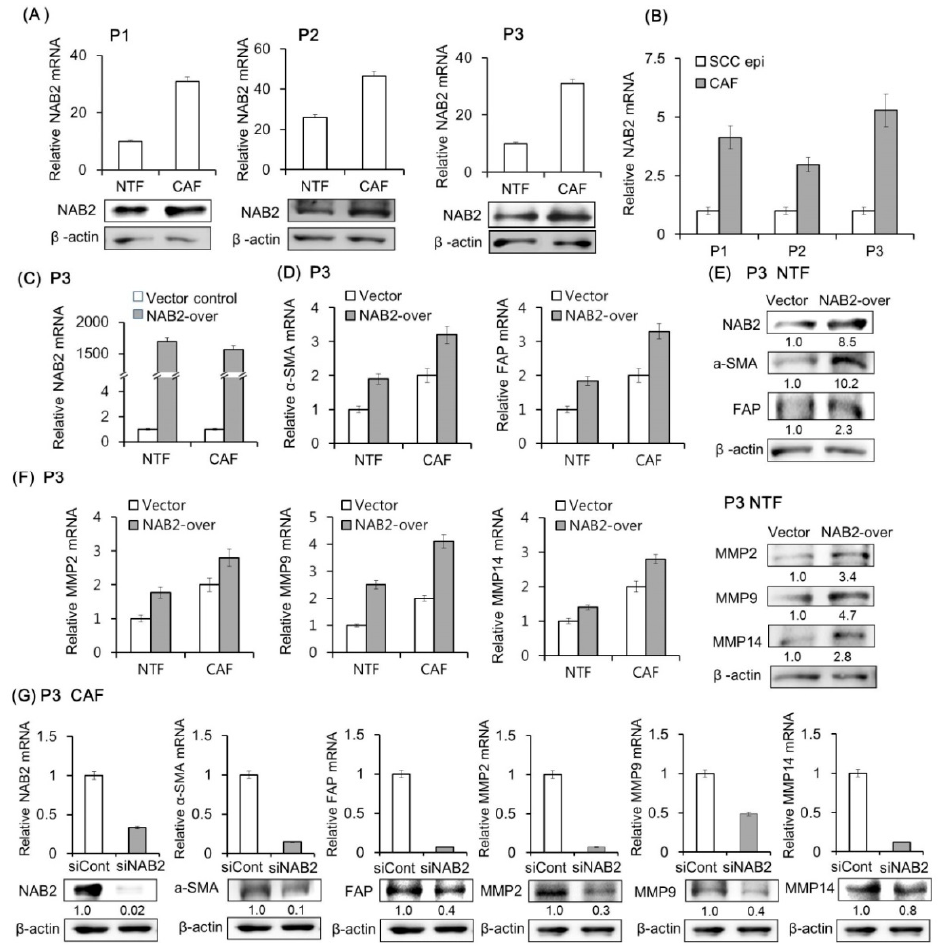
Figure 3. Effect of NAB2 on CAF marker and MMP expression in patient fibroblasts. ( A ) NAB2 mRNA and protein expression in CAFs and paired NTFs from tissue specimens of three HNSCC patients was analyzed by qPCR and Western blotting, respectively. ( B ) NAB2 mRNA level is compared in cultured CAFs and paired HNSCC tissues. ( C ) CAFs and NTFs form P3 were transfected with NAB2 overexpression (NAB2-over) or control vector for 48 h. ( D , E ) mRNA and protein levels of CAF markers were analyzed in NTFs transfected with NAB2-over or control vector. ( F ) mRNA and protein levels of MMPs were analyzed under the same conditions. ( G ) CAFs were transfected with control siRNA or siNAB2 mixture for 48 h, and mRNA and protein levels of NAB2, CAF markers, and MMPs were analyzed. Results represent the mean ± standard deviation of two or three experiments.